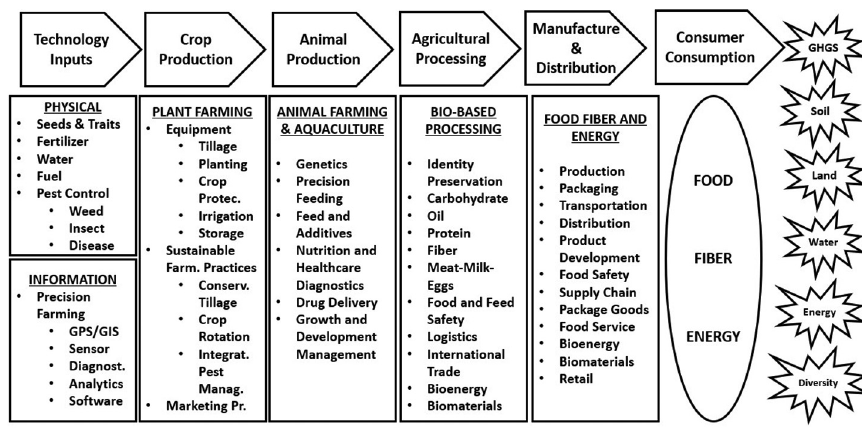
Figure 4. Agtech classi fi cation model proposed by